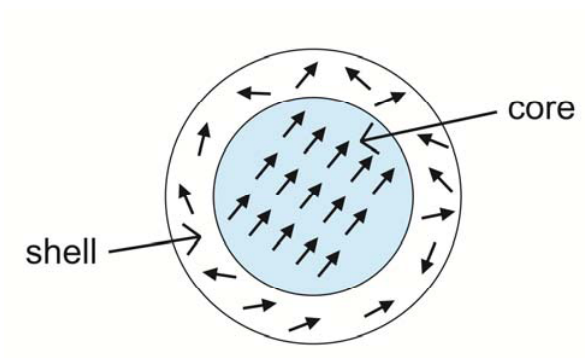
Figure1 – Schematic of the core-shell structure, I.e, the spin alignment of a spherical